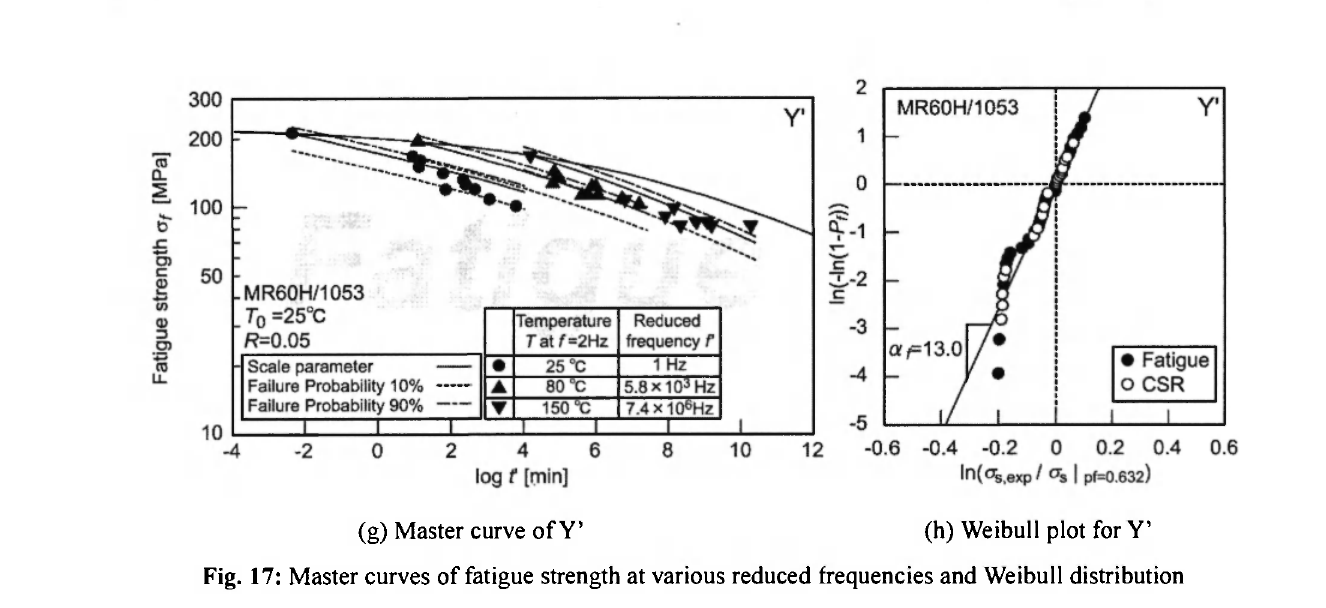
Fig. 17: Master curves of fatigue strength at various reduced frequencies and Weibull